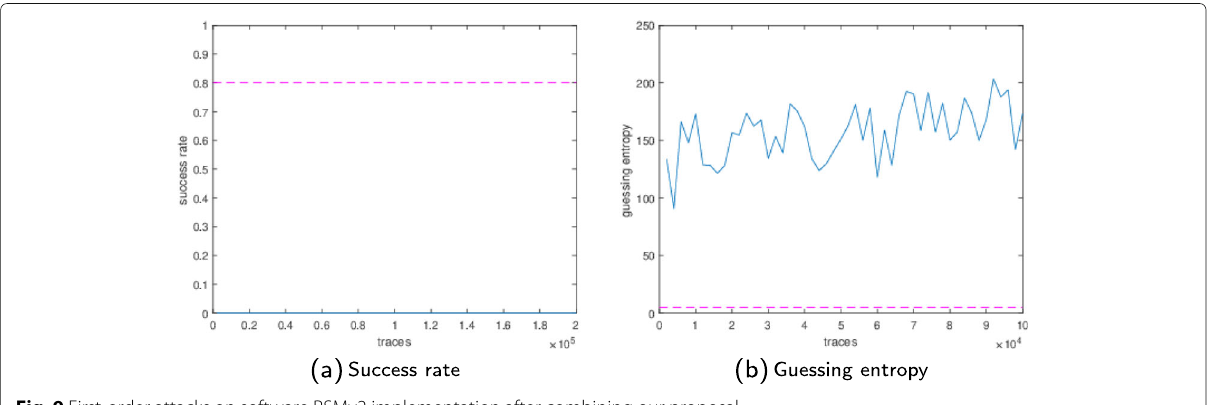
Fig. 9 First-order attacks on software RSMv2 implementation after combining our proposal